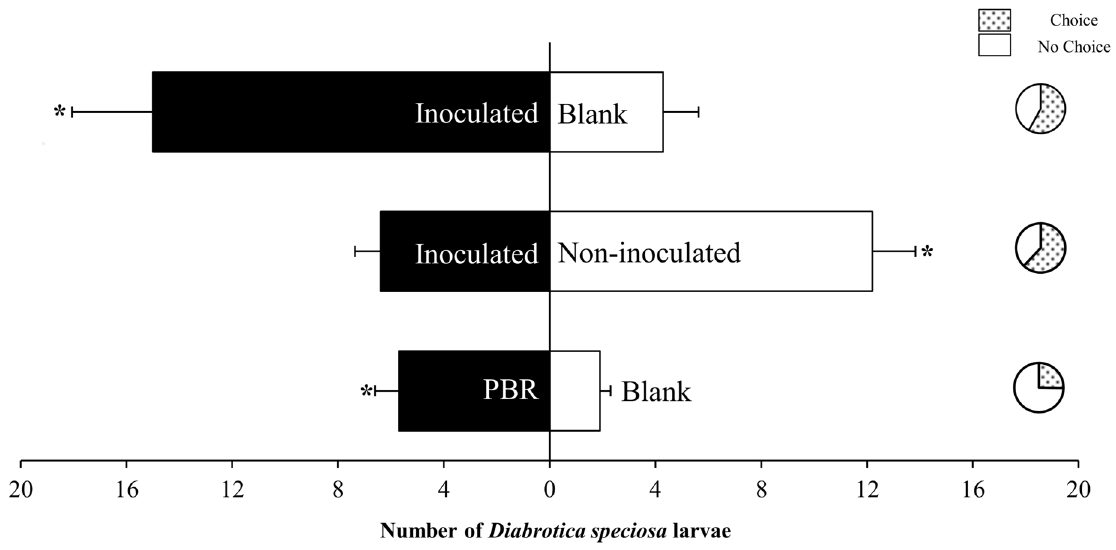
Figure 2. Effect of Azospirillumbrasilense on Diabroticaspeciosa larval host choice. Diabrotica speciosa larval choice between inoculated plants and the blank treatment (non-inoculated soil), inoculated and non-inoculated corn, and the plant-beneficial rhizobacterium (PBR) inoculant and the blank. Bars represent the mean number of larvae 6 SE. Pie charts on the right represent non-responsive (no choice) and responsive (choice) larvae. Asterisks indicate a significant difference between treatments according to a quasi-Poisson glm (n=10, P , 0.05).